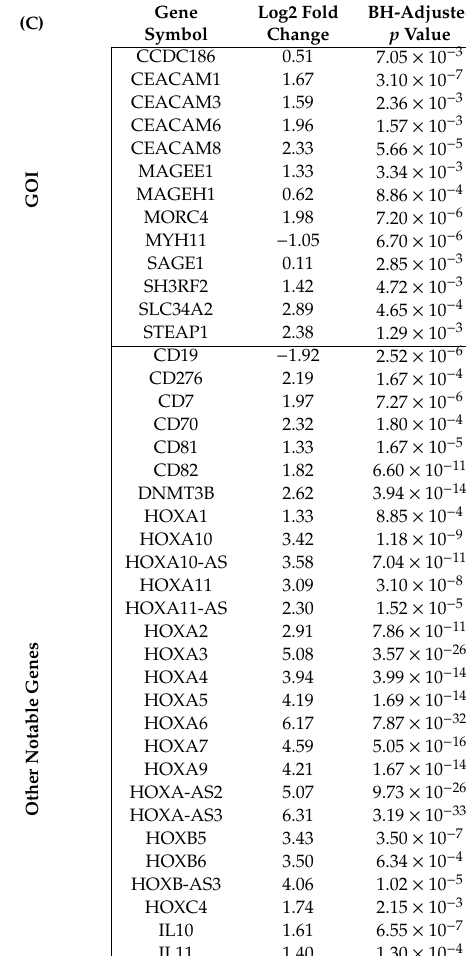
Table 1. Genes of Interest (GOI) and other notable genes identified as significantly di ff erentially expressed (BH-adjusted p < 0.01) between ( A ) standard and low risk subgroups within the TARGET dataset, ( B ) intermediate and good risk subgroups within the TCGA dataset, and ( C ) poor and good risk subgroups within the TCGA